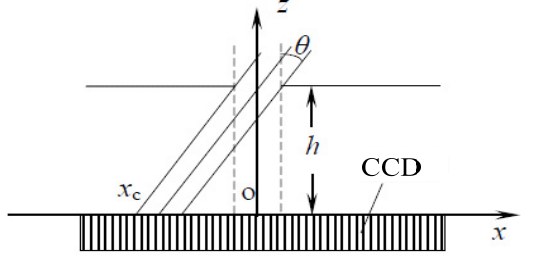
Figure 1. Schematic of digital sun sensor with single slit.